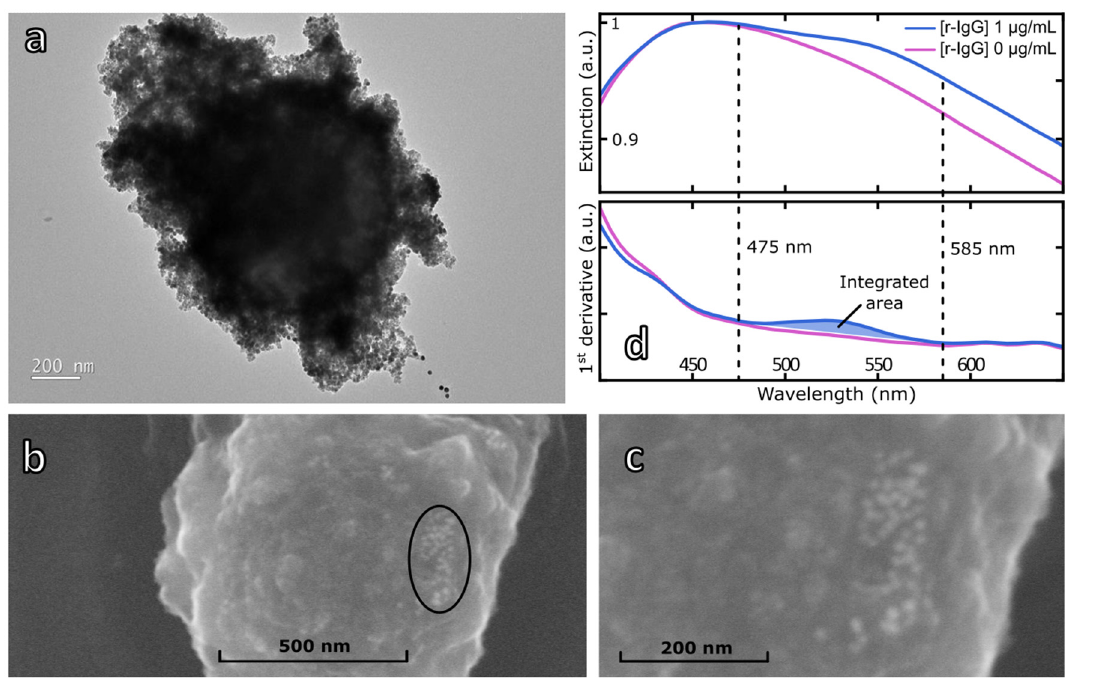
Figure 5. Physical characterizations of magneto-plasmonic immunocomplex. ( a ) TEM image (15,000×) and ( b ) SEM image (15 kV, 10.3 mm, 80,000×) of the magneto-plasmonic immunocomplex in the presence of 1 µg/mL of rIgG and a black circle showing the presence of AuNPs. ( c ) Zoom on the AuNPs. ( d ) Normalized and smoothed extinction spectra (top) and first order derivatives (bottom) of MB (pink trace) and immunocomplex resulting from the incubation of 1 µg/mL rabbit IgG and AuNP-Ab (blue trace).